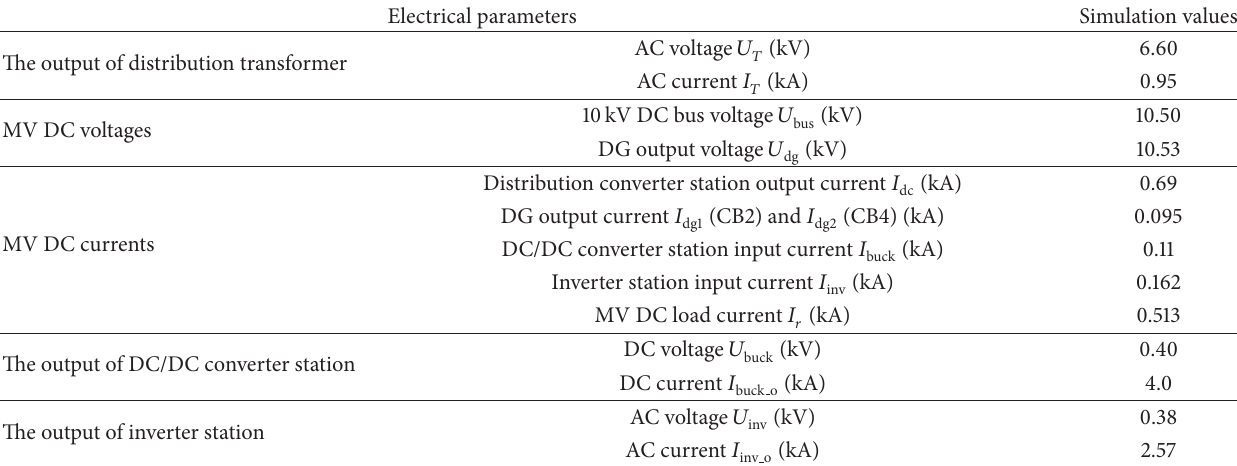
Table 1: Simulation values of electrical parameters in DC distribution